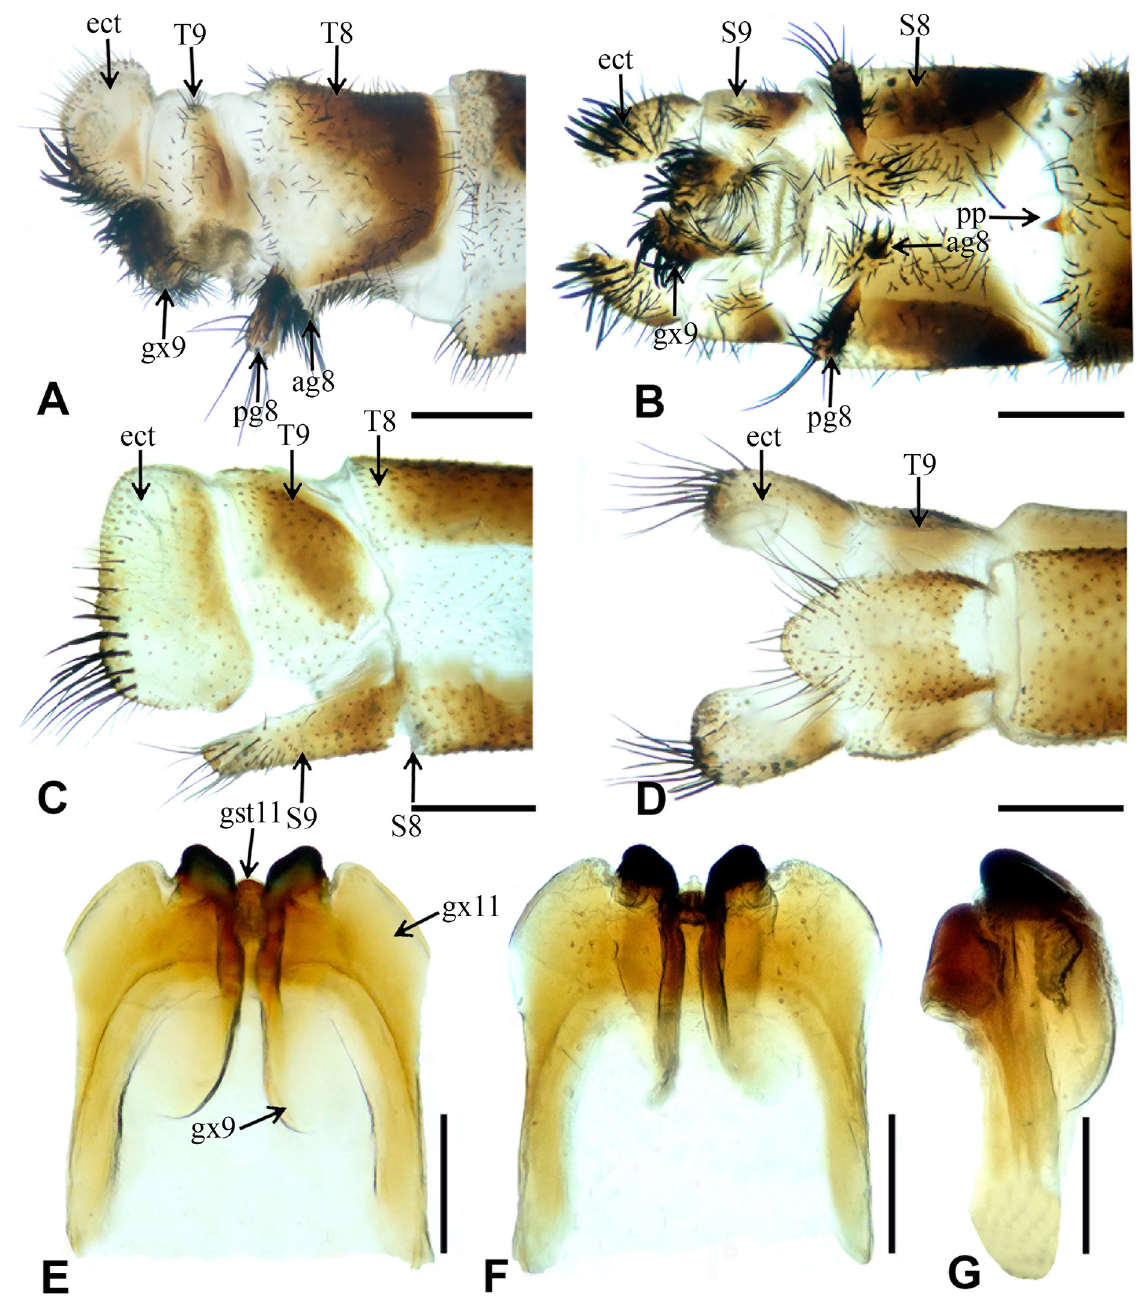
Fig. 9. Myrmeleon tenuipennis Rambur, 1842. A . Female genitalia, lateral view. B . Same, ventral view. C . Male genitalia, lateral view. D . Same, ventral view. E . Complex of gonocoxites 9 + gonocoxites 11, dorsal view. F . Same, ventral view. G . Same, lateral view. A–B: ♀ (CAUPK000011); C–G: ♂ (CAUPK000010). Abbreviations: ag8 = anterior gonocoxites 8; ect = ectoproct; gst11 = gonostylus 11; gx9 = gonocoxites 9; gx11 = gonocoxites 11; pg8 = posterior gonocoxites 8; pp = pregenital plate; S = sternites; T = tergites. Scale bars = 0.5